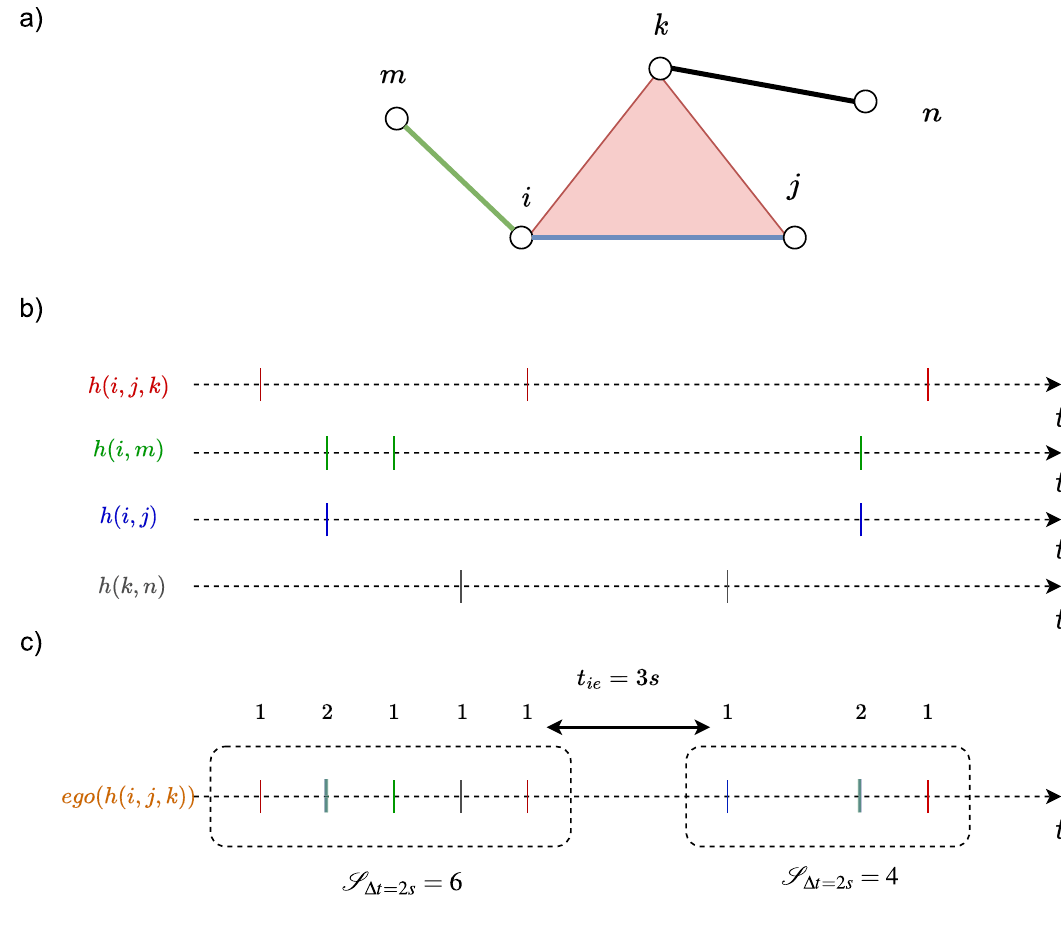
Figure 11. Schematic representation of ( a ) the egonetwork of the hyperlink h ( i , j , k ) , i.e. ego ( h ( i , j , k )), ( b ) the time series associated to links belonging to ego ( h ( i , j , k )) , ( c ) the time series of the activity of ego ( h ( i , j , k )) , which is the sum of the time series of hyperlinks belonging to the egonetwork, and its event trains identified when (cid:31) t = 2 s